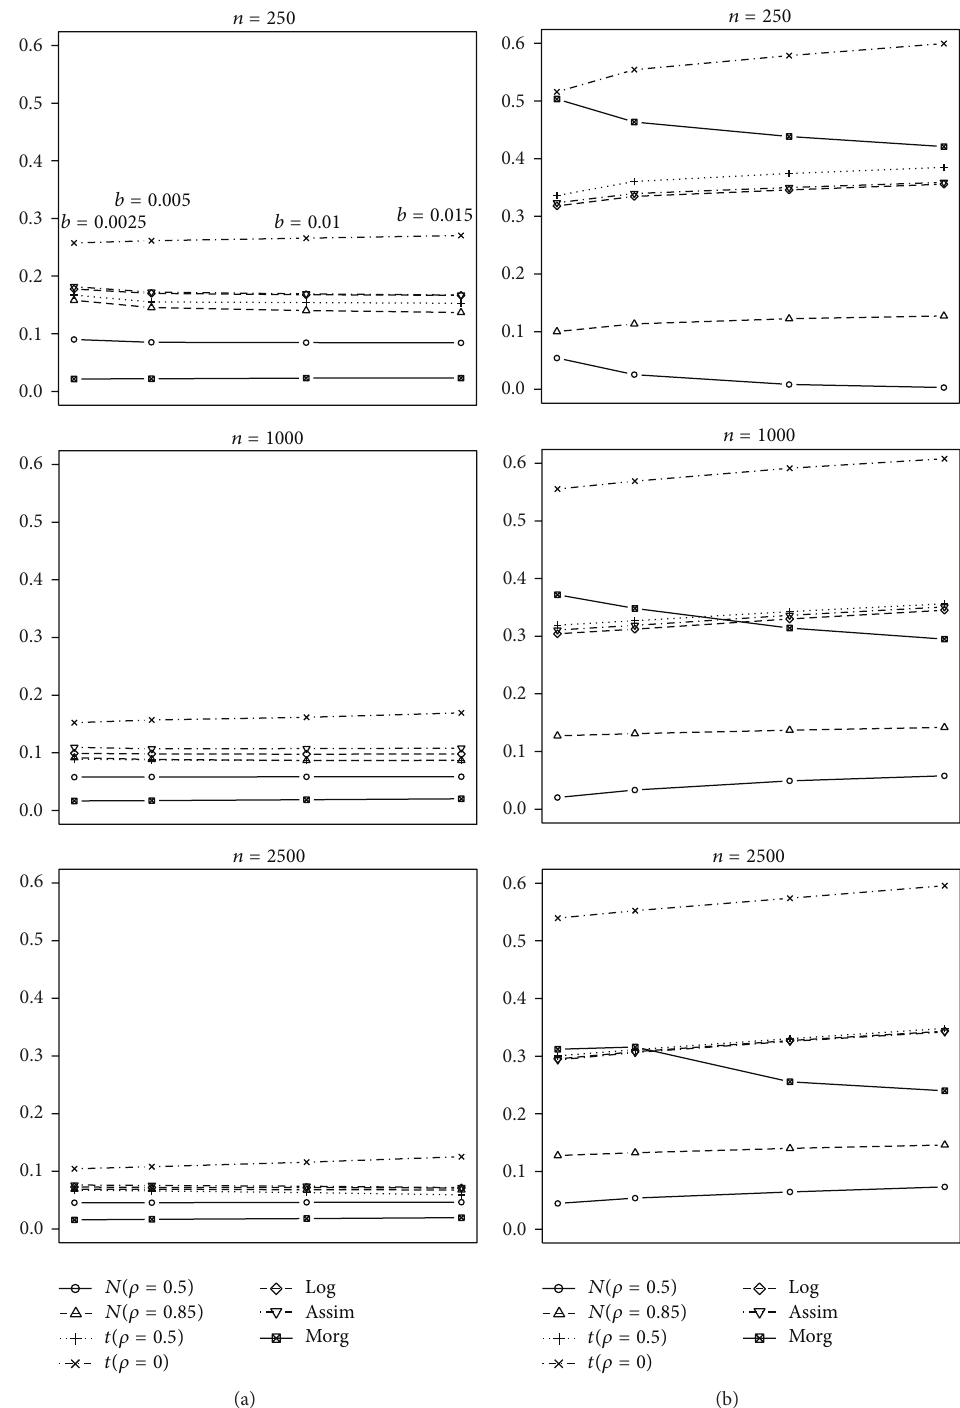
̂𝜒 (b). The four values plotted in each line correspond to 𝑏 = 0.0025, 0.005, 0.01, 0.015 ,